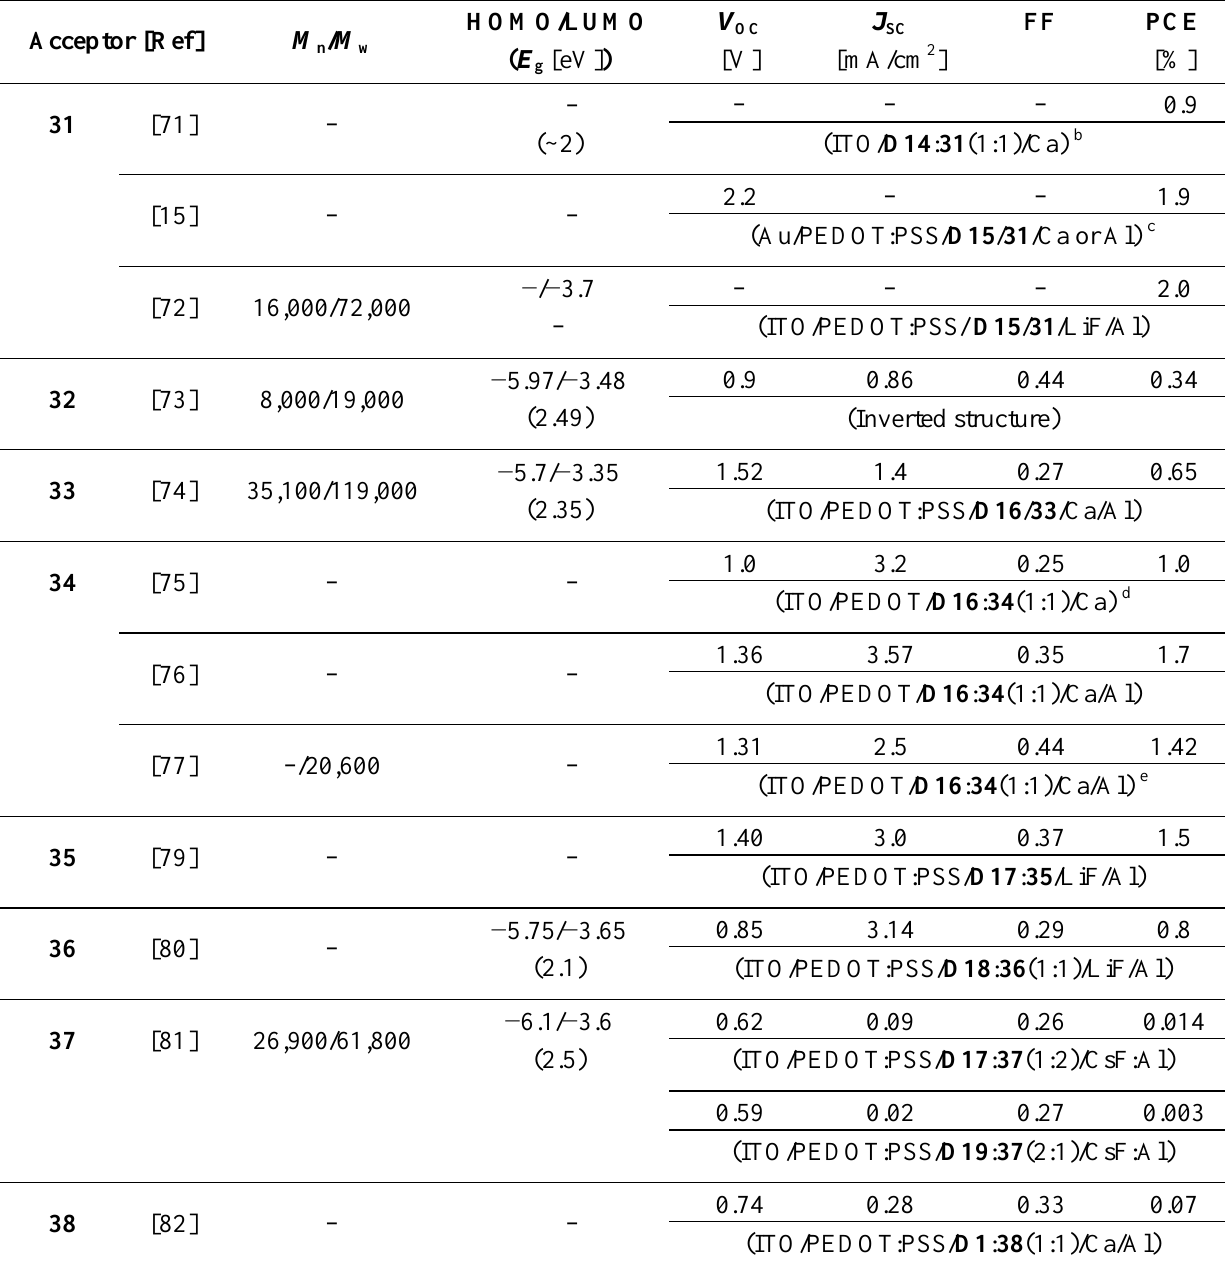
Table 4. CN-substituted polymer acceptors a